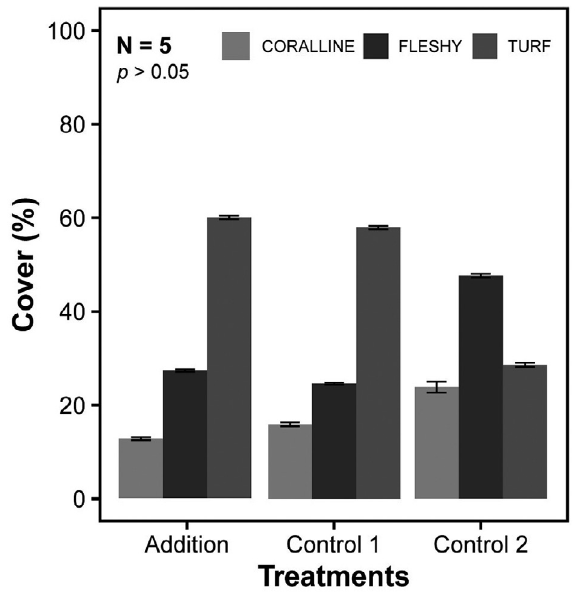
Fig. 3. – The total species of macroalgae in each functional group per treatment with the error bars showing the standard deviation indicating the variation in data measurement. tyon variabile and the coralline Jania pumila were the most dominant, along with green FTA such as Clado- phora laetevirens and Cladophora vagabunda , and CA such as Caulerpa lanuginosa